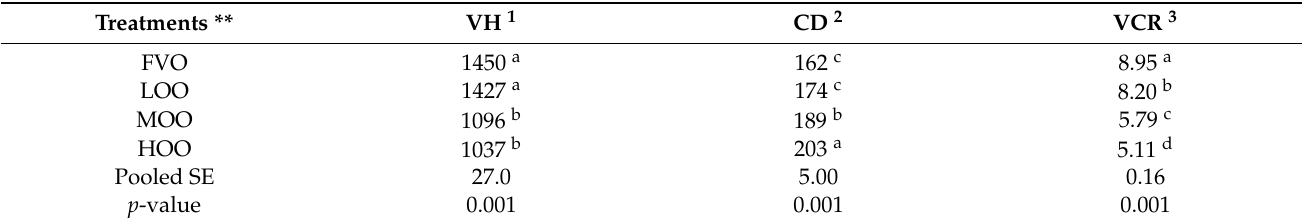
Table 3. Effects of oxidized vegetable oil on villus height ( µ m), crypt depth ( µ m) and villus height to crypt depth ratio in broilers *. Treatments **